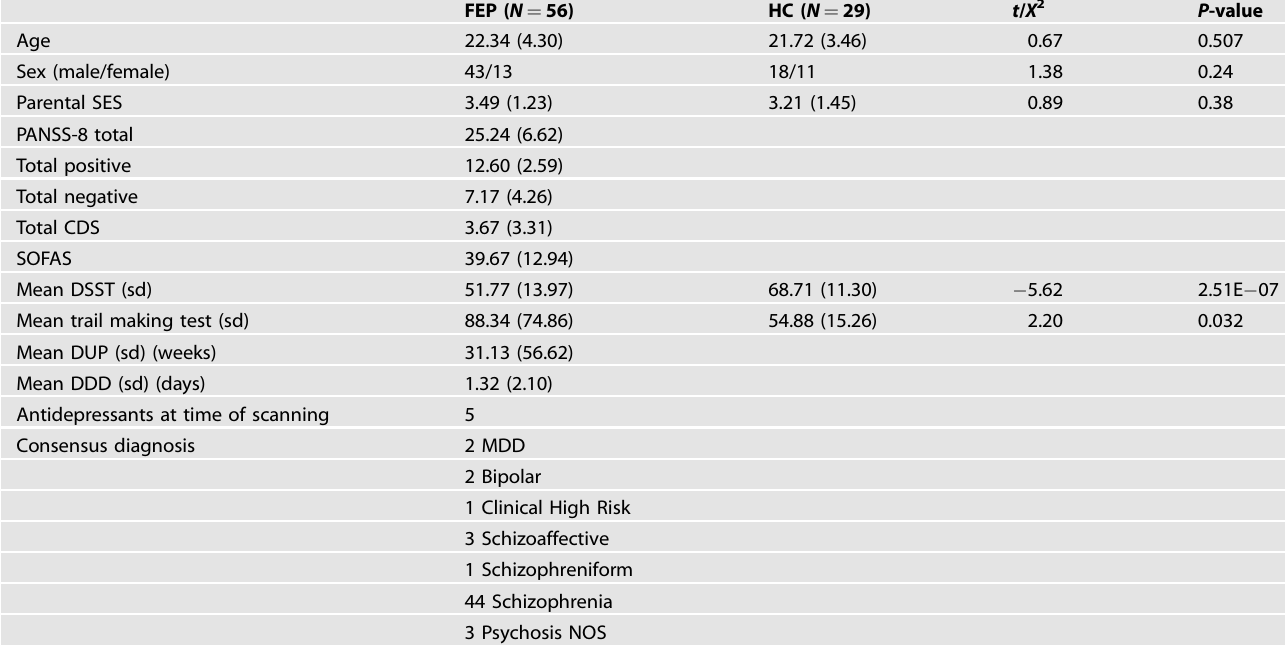
Table 1. Summary of sample demographics and clinical